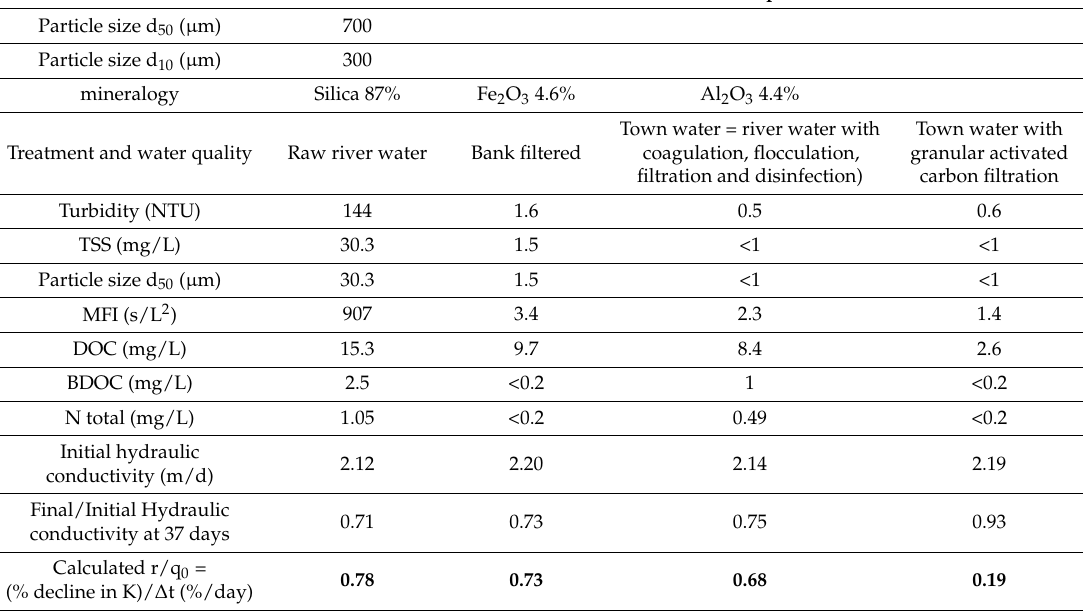
Table 6. Summary of column study tests of clogging with Menindee sand and Darling River water with different treatments (from Page et al.